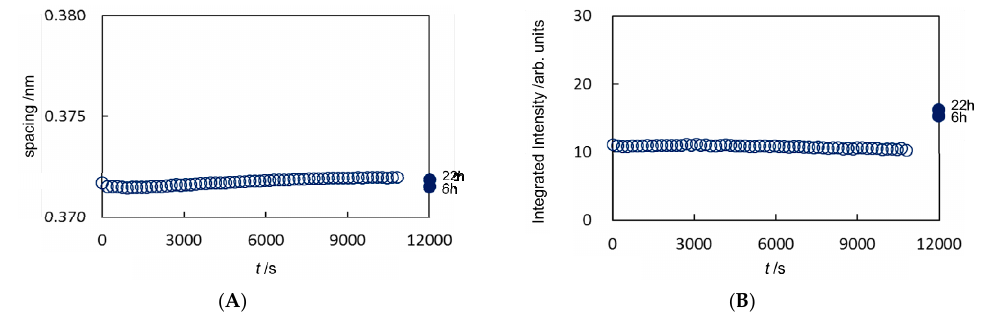
Figure 3 . Analyzed results in the stratum corneum treated with ethanol for sample #E1. ( A ) Change of the spacing of the hydrocarbon-chain packing structure at the lattice constant 0.37 nm; ( B ) change of its integrated intensity.